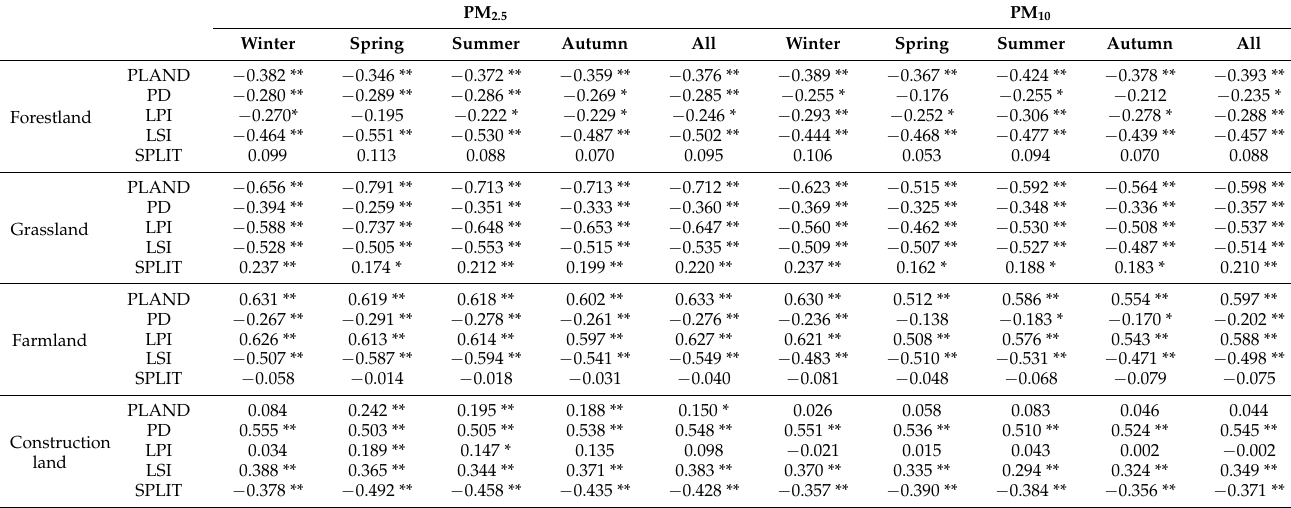
Table 7. Correlations between the particle concentration and indices at the class